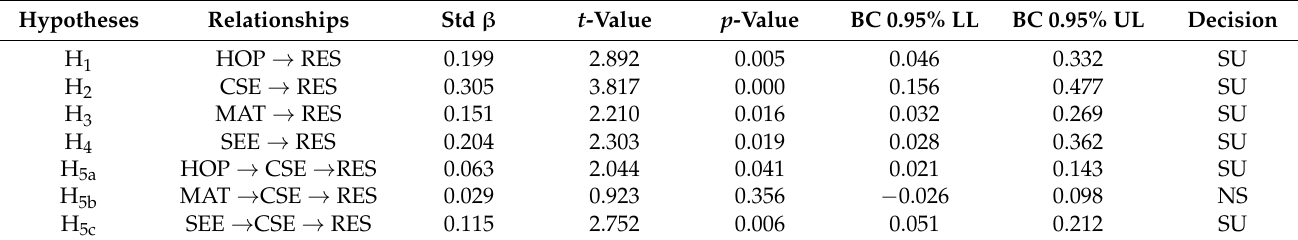
Table 5. Hypotheses testing.